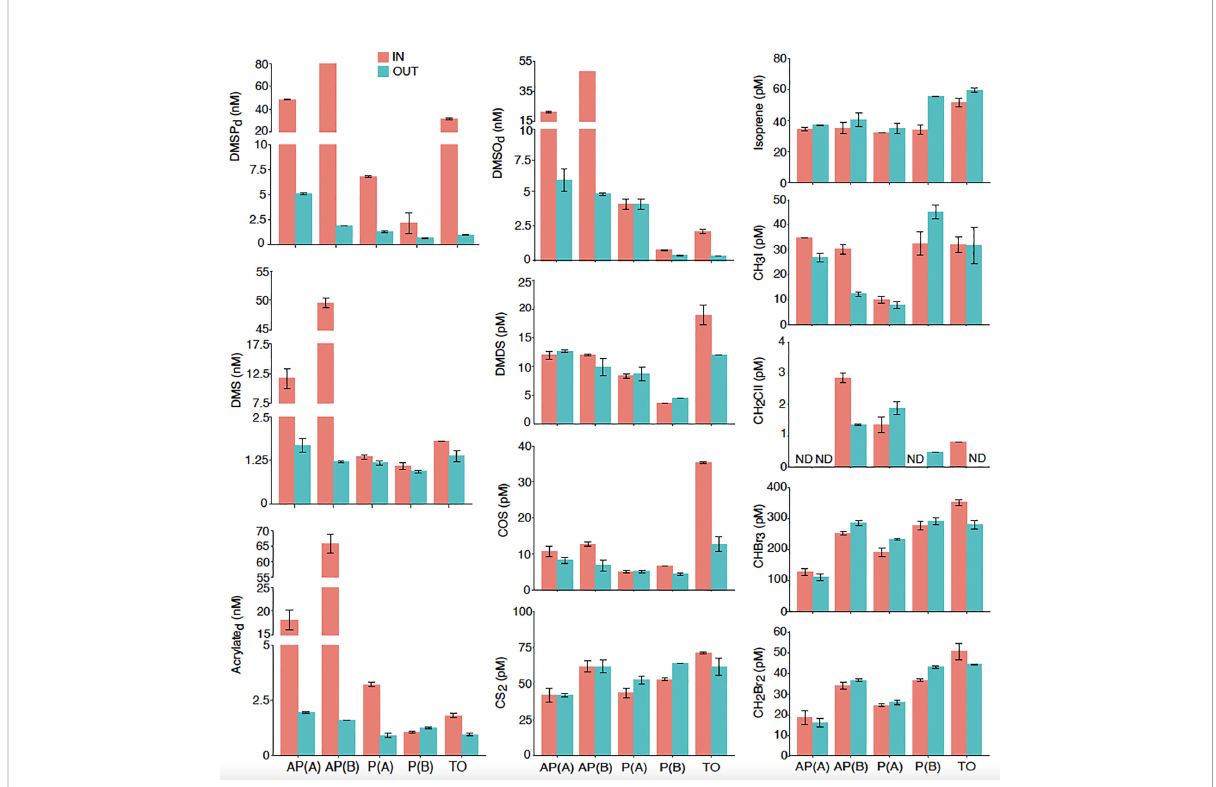
FIGURE 4 Dissolved DMSPC and VOC concentrations in the close vicinity (IN) and 2 m away (OUT) of two colonies of the coral Acropora pulchra [AP(A) and AP(B)], two colonies of the coral Pocillopora sp. [P(A) and P(B)], and a patch of the seaweed Turbinaria ornata (TO). Error bars denote the standard error of duplicate analyses. ND, not